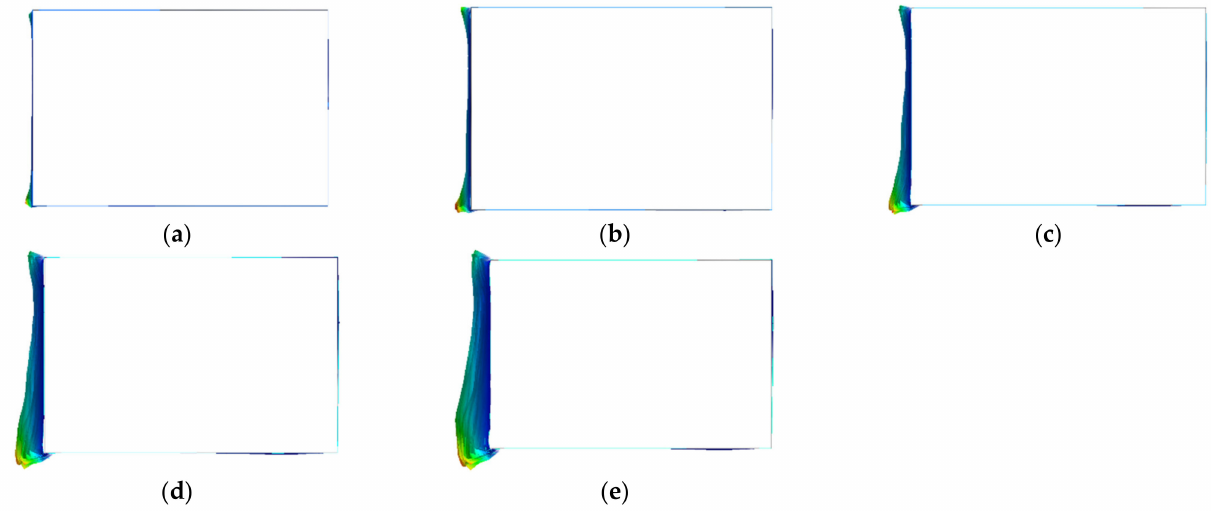
Figure 4. Side view of ice distribution of beams at different wind speeds. ( a ) The wind speed is 5 m/s. ( b ) The wind speed is 10 m/s. ( c ) The wind speed is 15 m/s. ( d ) The wind speed is 20 m/s. ( e ) The wind speed is 25 m/s.